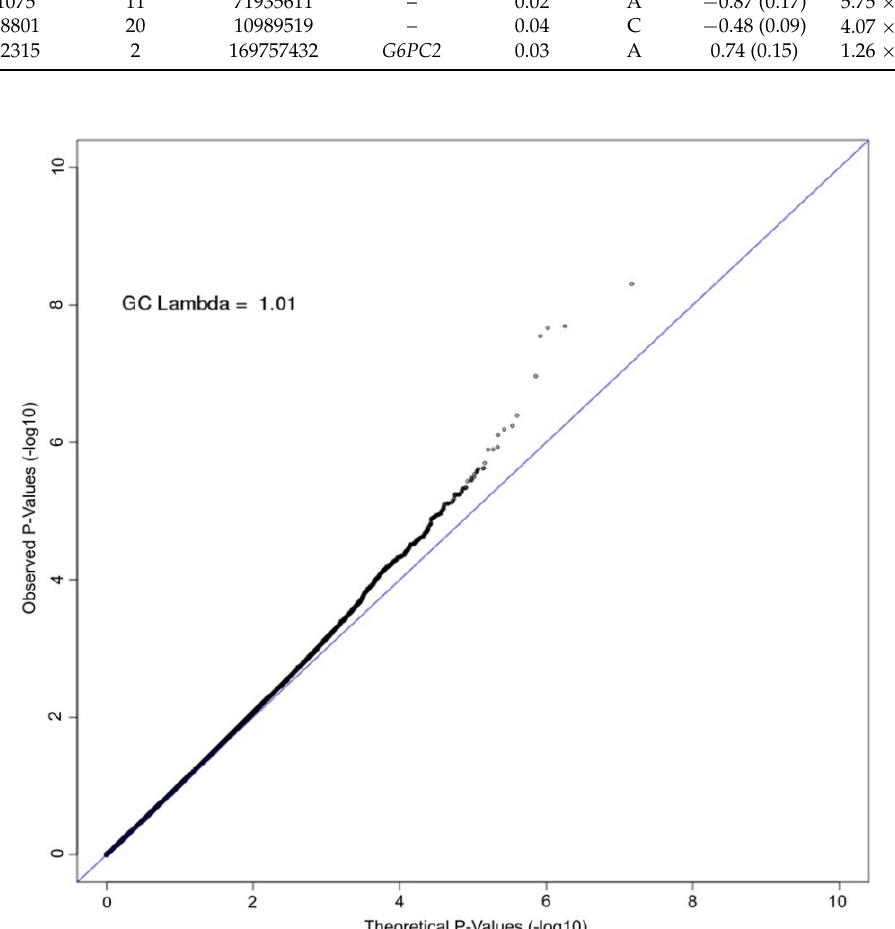
Figure 3. Quantile-quantile (QQ) plot of GWAS of serum lycopene concentrations. The axes plot the observed (y-axis) vs. theoretical (x-axis) association p -values on the log scale for all single nucleotide polymorphisms (SNPs) with minor allele frequency (MAF) greater than 2%. The Old Order Amish are a closed founder populations with little admixture expected. The genomic control lambda is estimated to be 1.01, indicating little bias due to population stratification.